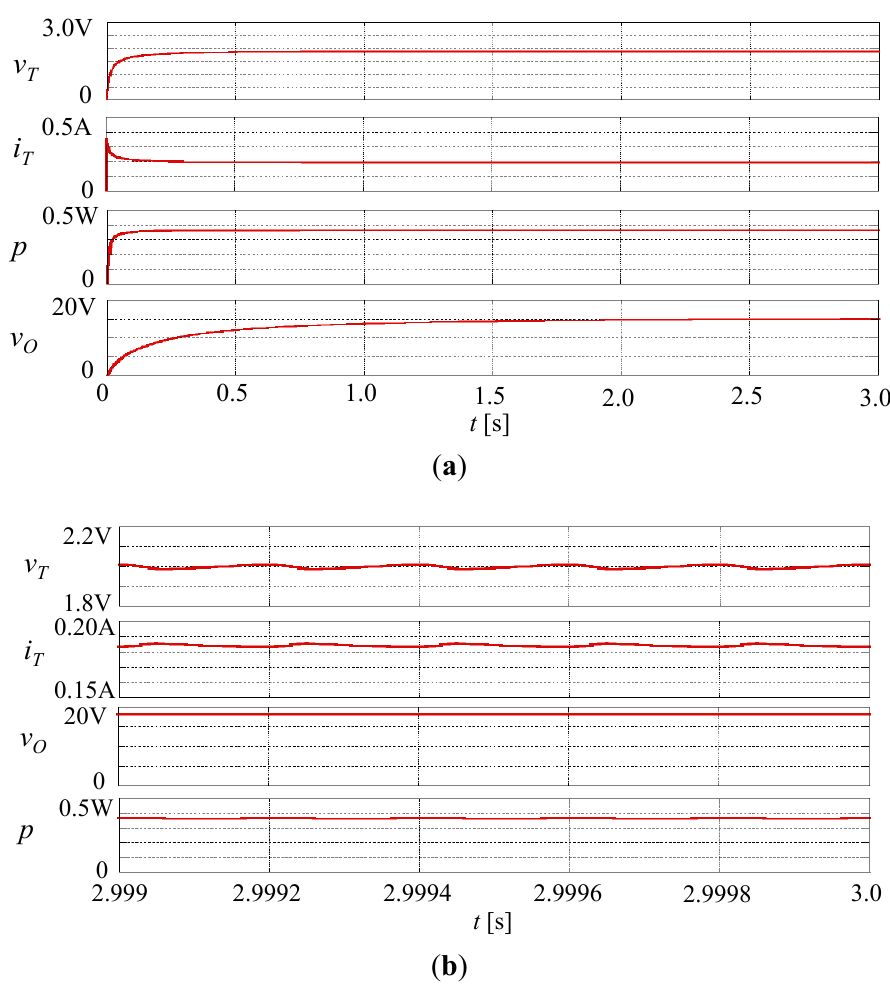
Figure 8. Simulated results by using the conventional hill-climb method when the thermal difference is 35 °C. ( a ) During the starting period; ( b ) Magnified waveforms in the vicinity of 3.0